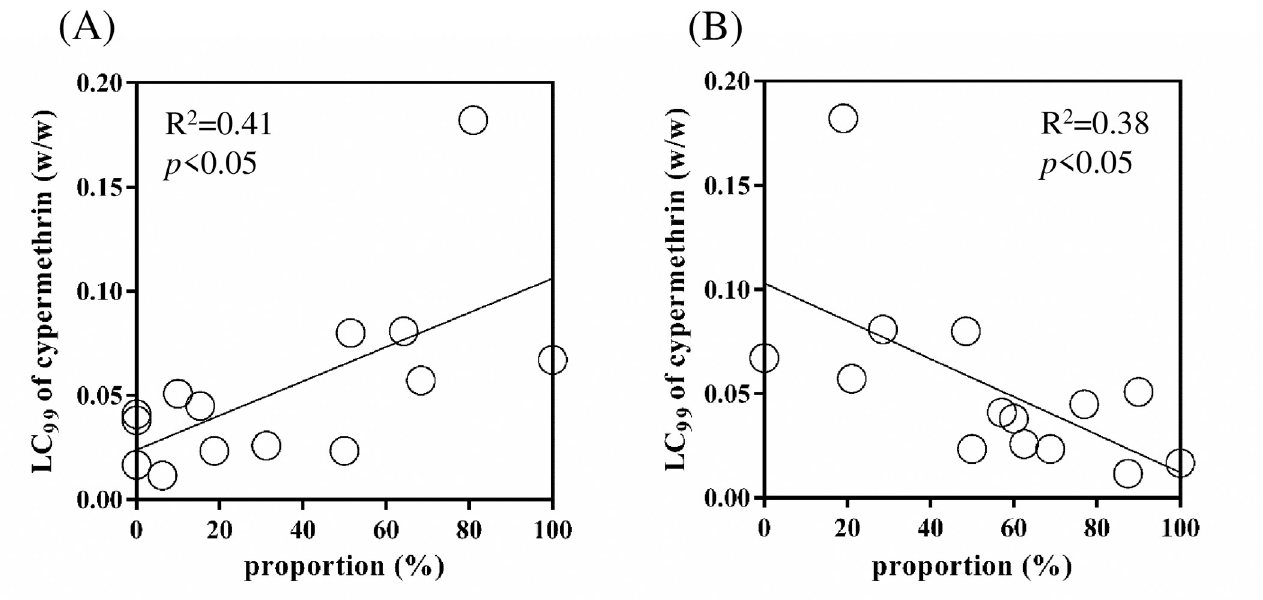
Fig 4. Relationship between cypermethrin susceptibility and totalized proportion of specific vgsc genotypes. (A) Resistance associated 7 vgsc genotypes or (B) Resistance unrelated 4 vgsc genotypes were correlated with the LC99 of cypermethrin in each district. Open circles represent administrative districts in either March or October. R 2 was calculated by Pearson’s correlation